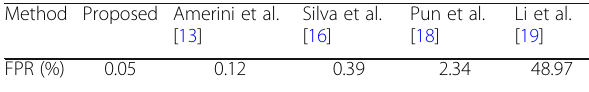
Silva et al. Pun et al. Li et al. [16] [18]